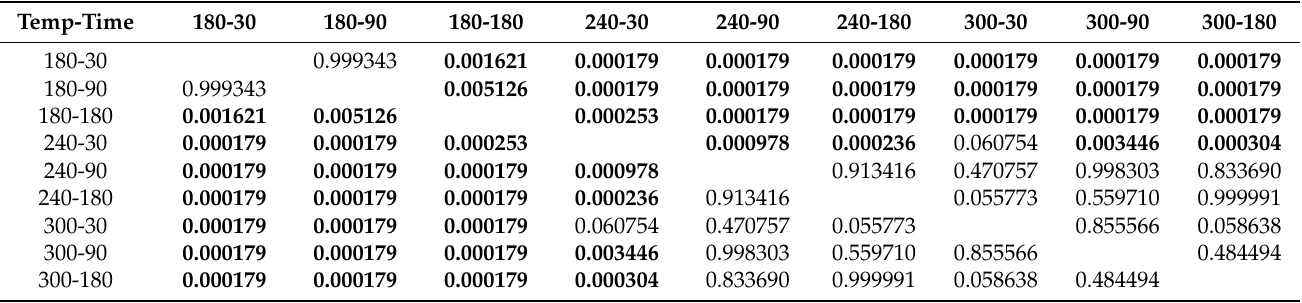
Table A10. Two-way analysis of variance (ANOVA) with post hoc Tukey test for AC , a bold font signifies a statistically significant difference ( p <